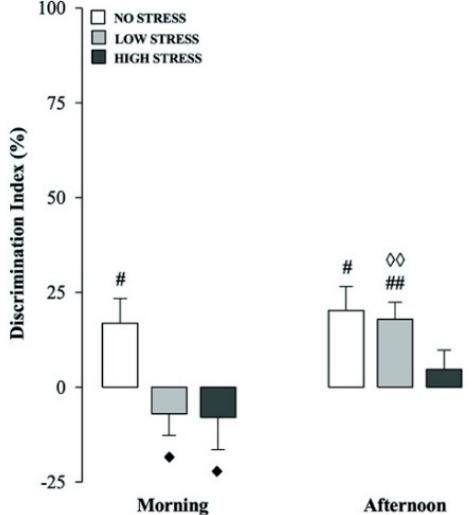
Figure 3. Different stress intensities and time-of-day effects on short-term memory. Discrimination index on the testing trial for intra-CA1 vehicle-treated rats belonging to the no, low or high stress condition groups that were tested in the morning or afternoon. Post hoc comparisons revealed significant differences between groups as follows: ♦ p < 0.05 vs the corresponding no stress group. ♢♢ p < 0.01 vs the corresponding low stress morning group. # p < 0.05, ## p < 0.01, one-sample t-tests significantly different from zero. Data are expressed as mean ± SEM ( n = 10–12 per group). Table 2. Exploratory behavior on the testing trial for vehicle- and KML29-treated rats that were subjected to no, low or high stress conditions immediately after the training trial, in the morning or afternoon.